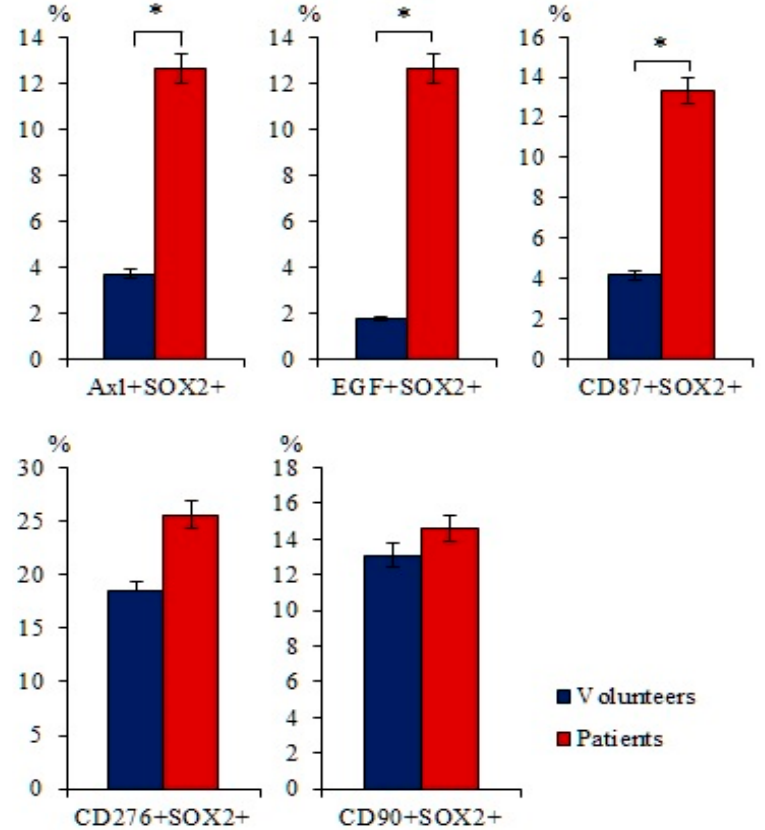
Figure 3. The content of Axl + SOX2 + , EGF + SOX2 + , CD87 + SOX2 + , CD276 + SOX2 + , and CD90 + SOX2 + circulating tumor cells (CTCs) isolated from the blood of patients with SCLS and healthy volunteers (% of all labelled mononuclear cells). Cells were analyzed by flow cytometry using antibodies for Axl, EGF, CD87, CD276, CD90, and SOX2. * Differences are significant in comparison with volunteers ( p < 0.05).